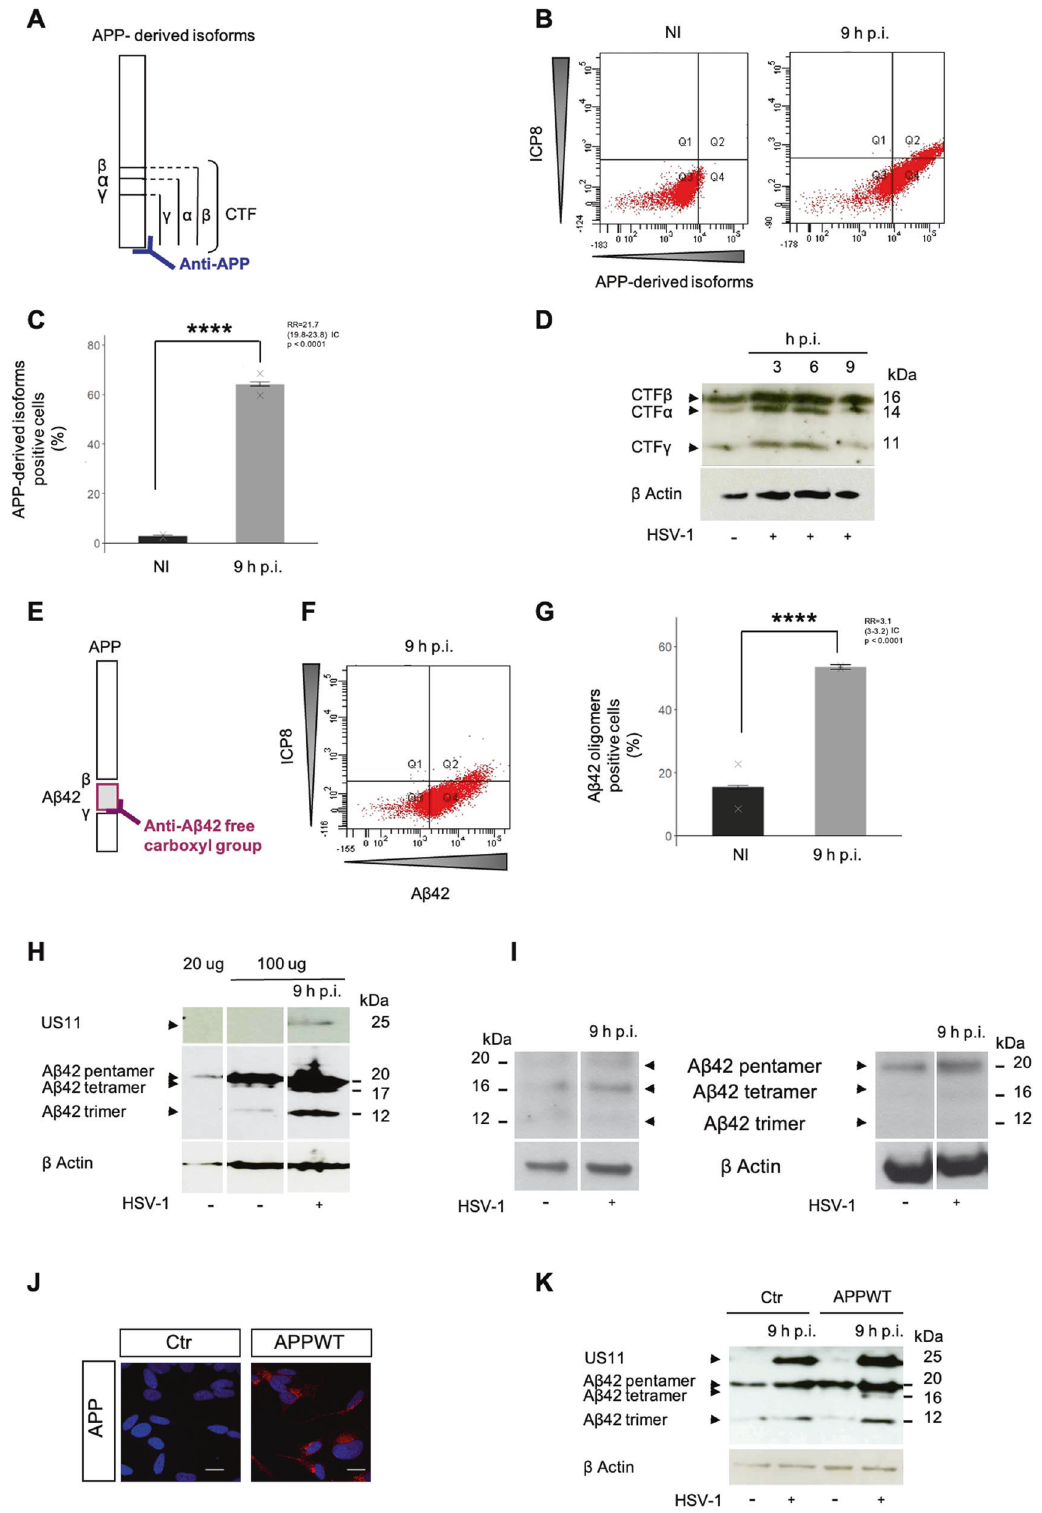
the lower molecular weight fragments CTF α , β and γ , increased until 9 h p.i. (Fig. 2D) despite of the decrease of the amount of APP. FACS analysis with anti-A β 42 C-Ter antibody (Fig. 2E, F) highlighted an increase of A β 42 accumulation between NI and 9 h p.i. about 3 times (Fig. 2G, RR value). This discrepancy between increase of